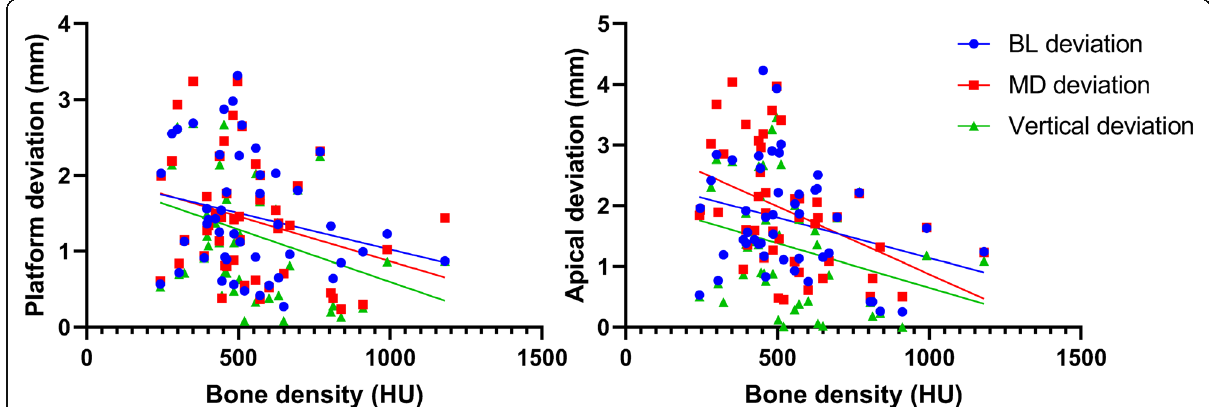
Fig. 5 Scatter plot showing a linear correlation between bone density and implant deviation. Left: deviation at the implant platform; right: deviation at the implant